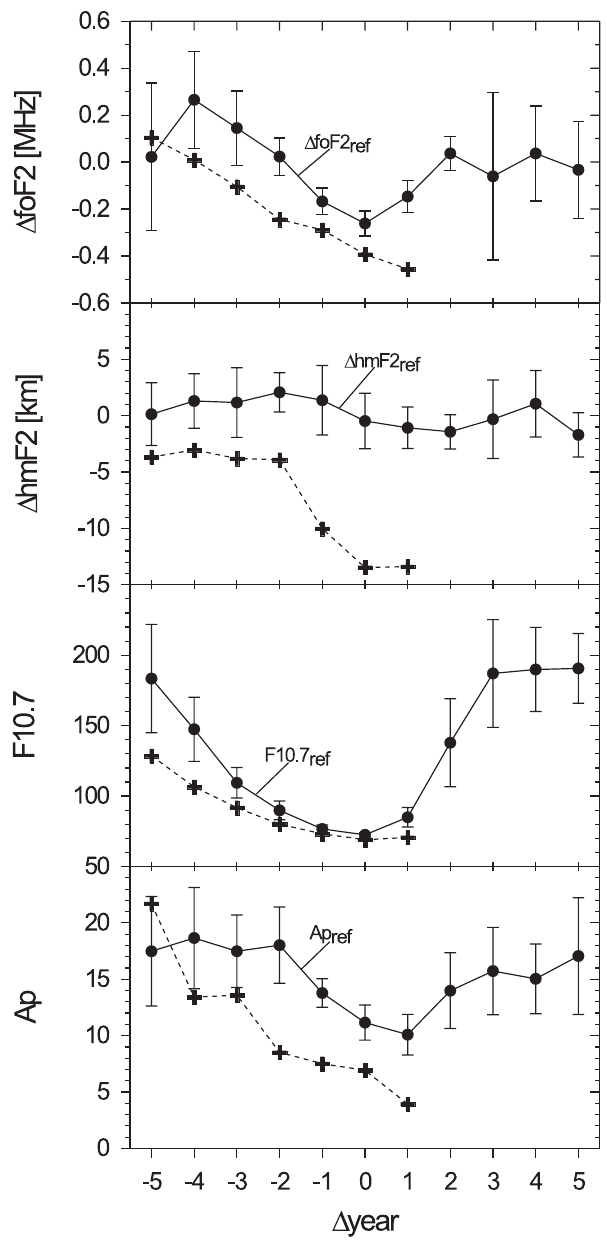
Fig. 12. Comparison of global yearly mean values of 1 fo F2, 1 hm F2, F10.7, and Ap values from the years 2003 until 2009 (crosses connected with dashed lines) with corresponding reference values derived by a superimposed epoch analysis from the previous solar minima (full dots with error bars connected with continuous